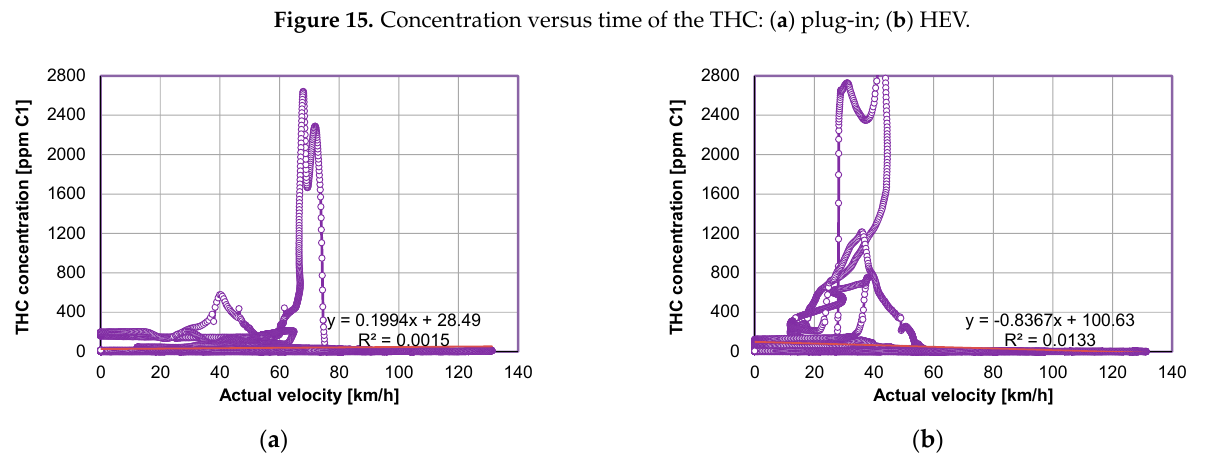
Figure 16. The THC concentration versus actual velocity for: ( a ) plug-in; ( b ) HEV. Similar to the case of CO concentration, except for the sudden jumps, in the case of the plug-in, the THC concentration slowly increased with the increase in the actual velocity up to 110 km/h and then stabilized, reaching several hundred ppm. This was due to